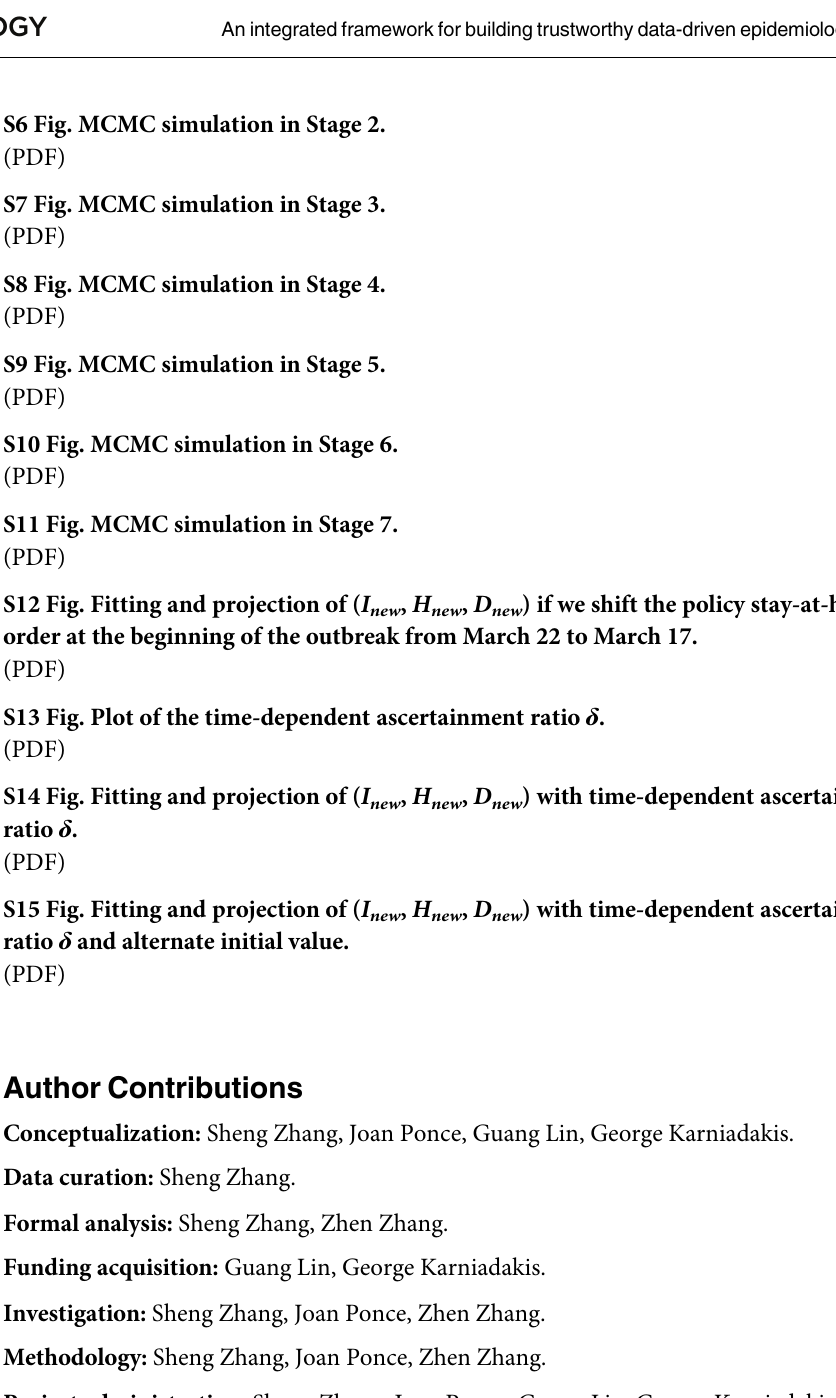
, H , D ) with time-dependent ascertainment new new new